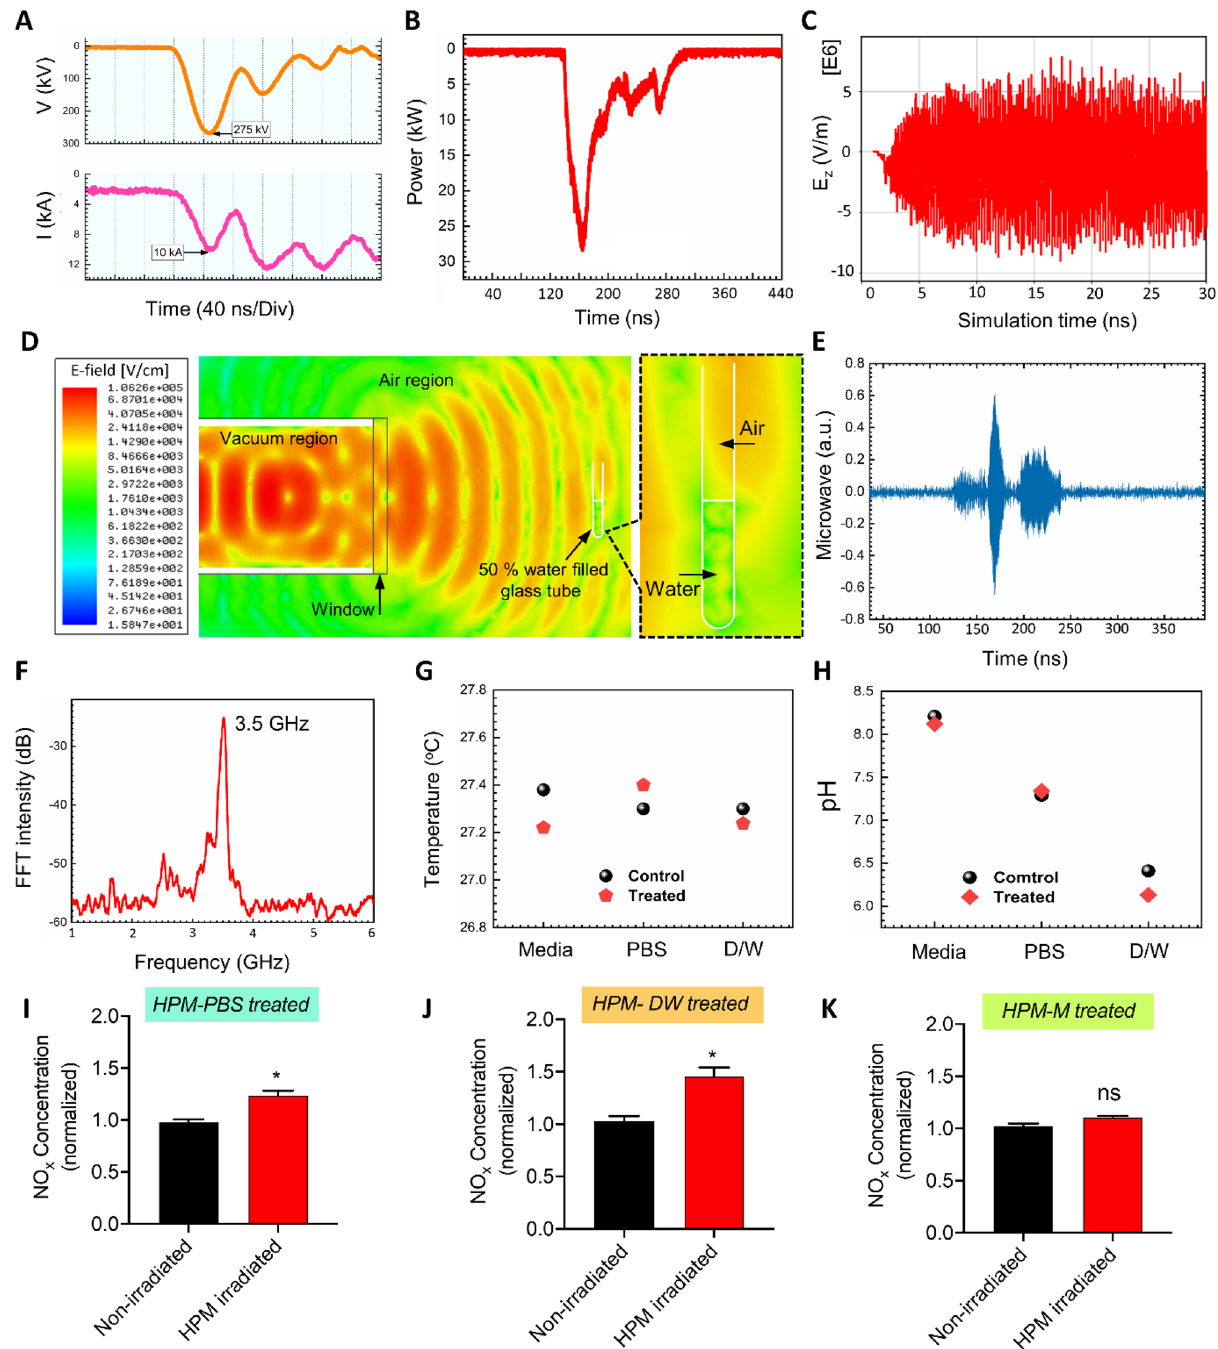
Figure 2. Physical characteristics of the high power microwave exposure device “Chundoong”. ( A ) Diode voltage and diode current, ( B ) Microwave envelope signal, ( C ) Axial electric field from simulation, ( D ) Electric field from HFSS simulation, ( E ) Microwave realsignal, ( F ) Dominant frequency of the microwaves, ( G ) Temperature of the solution before and after microwave exposure, ( H ) pH of the solution before and after microwave exposure, and NO x concentration in ( I ) PBS, ( J ) water, and ( K ) cell culture